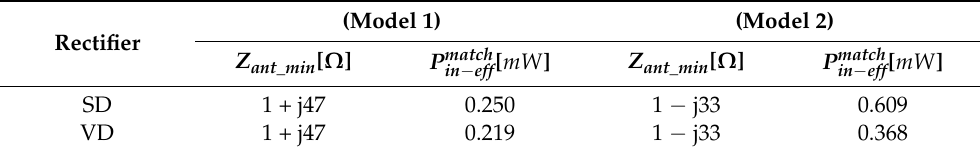
Table 4. Antenna impedance to minimize the input apparent power P match and the minimum in- put power for each rectifier.